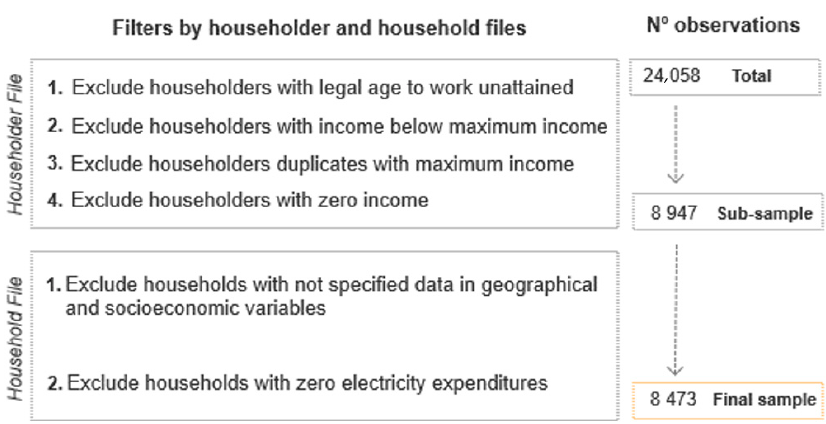
Figure 1. Filters by householder and household files for final sample .